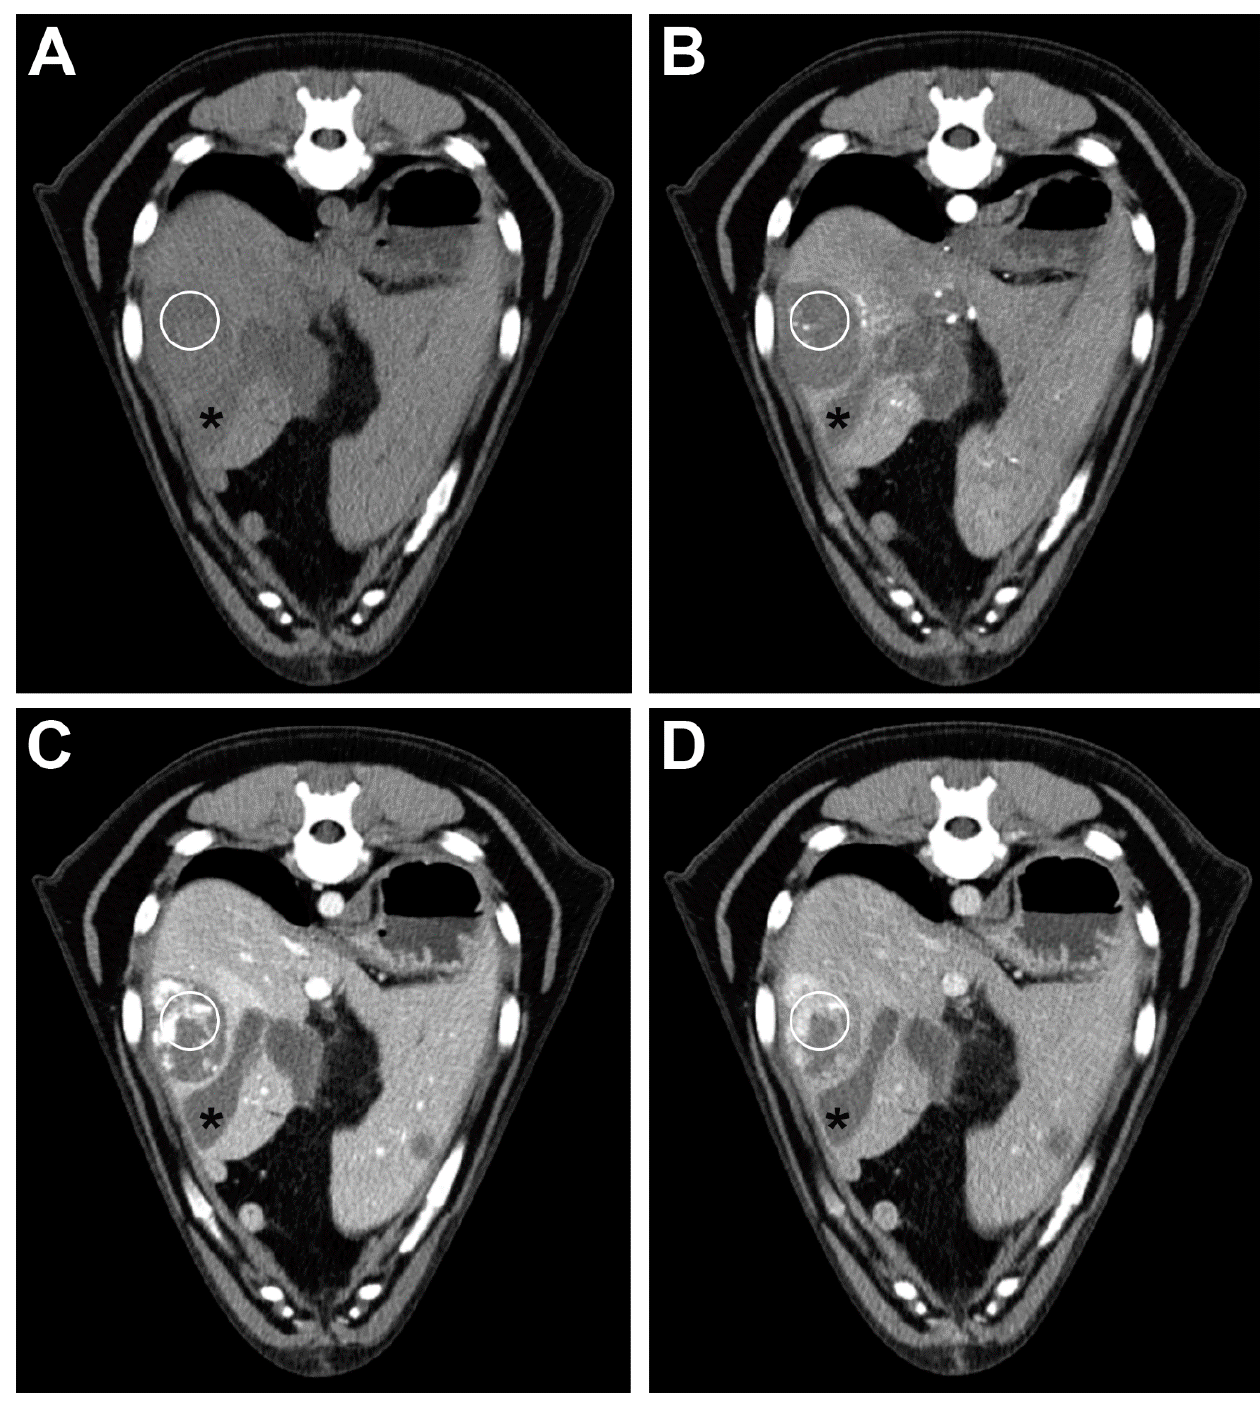
Figure 1. Transverse plane images of a TP-MDCT in a dog with hepatic hemangiosarcoma. The pre-contrast ( A ) and arterial ( B ) phase images show a hypoattenuating lesion in the right hepatic division. In the portal ( C ) and delayed ( D ) phase, the lesion is partially contrast-enhancing, with a non-enhanced hypoattenuating area. Asterisk = gallbladder; the white circle shows the location of the ROI used for the measurement.